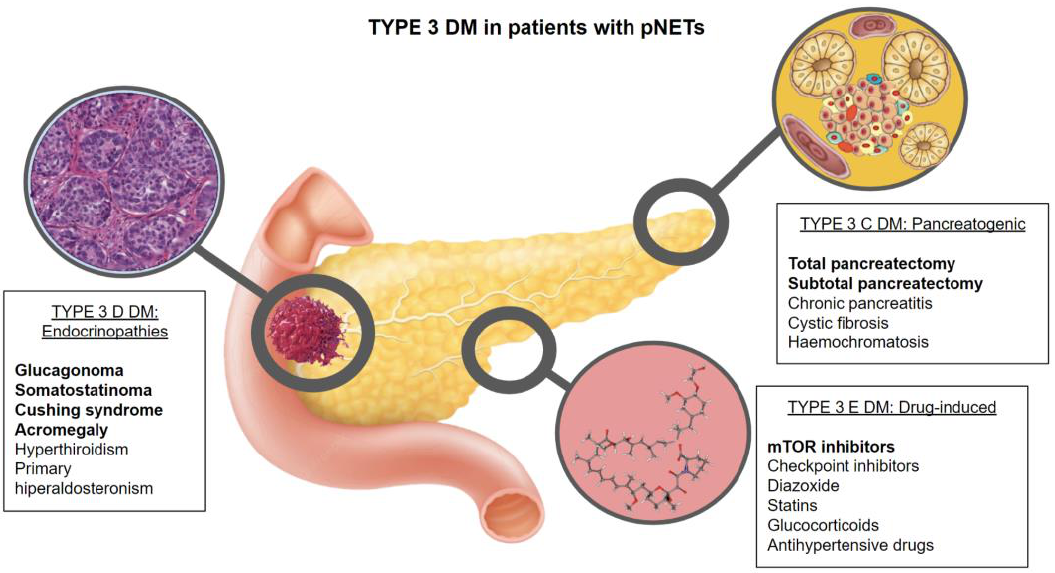
Figure 1. Schematic figure of the pathophysiology of type 3 DM in patients with pNETs.